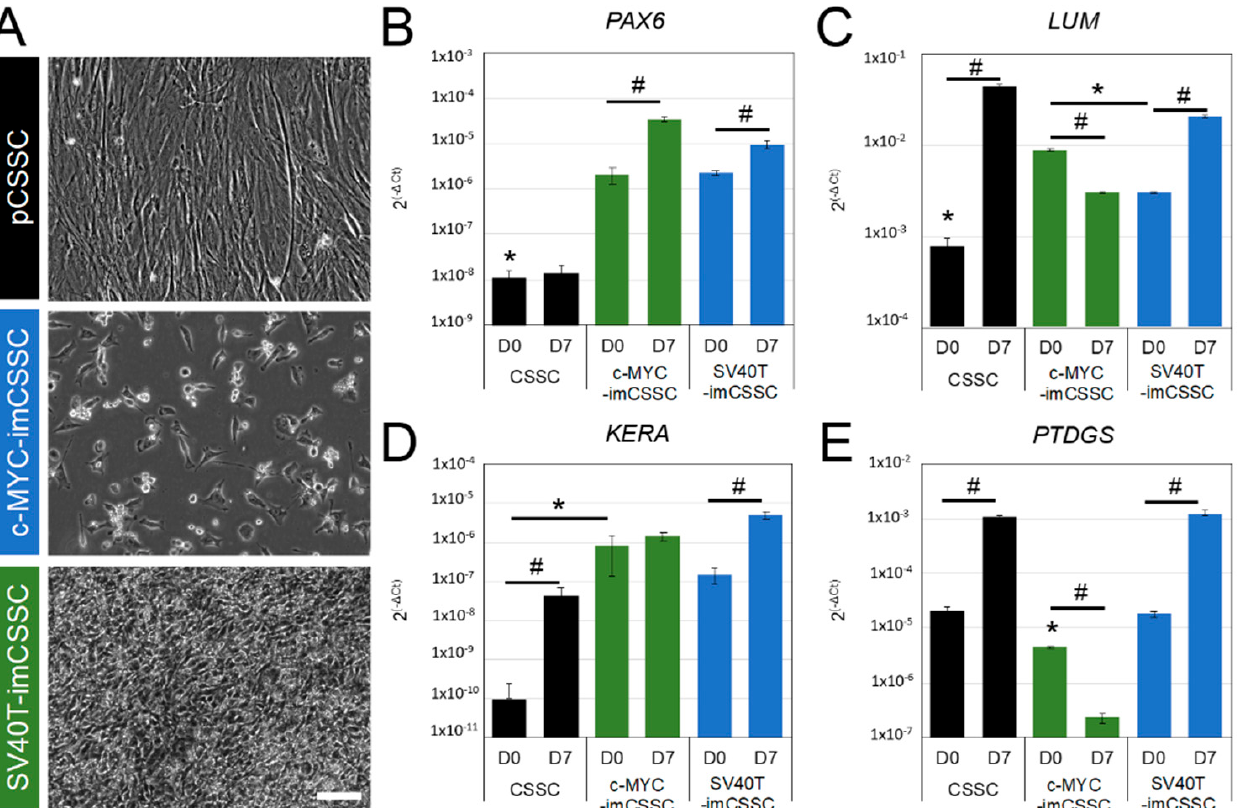
Figure 4. Differentiation capacity of generated CSSC lines towards keratocyte lineage. ( A ) Phase- contrast microscopy pictures of pCSSC and imCSSC lines after 7 days of keratocyte induction. Scale